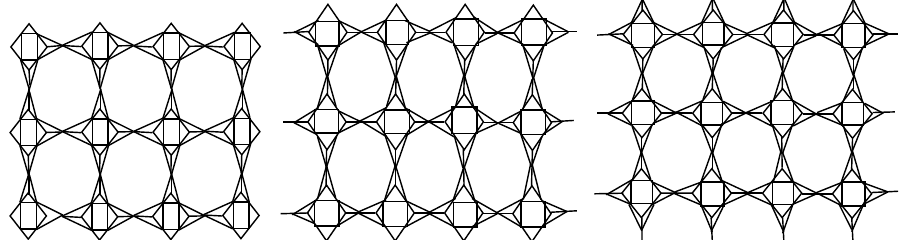
Figure 3: Semi-total(line) graph of 2 D -Lattice, Nanotube,